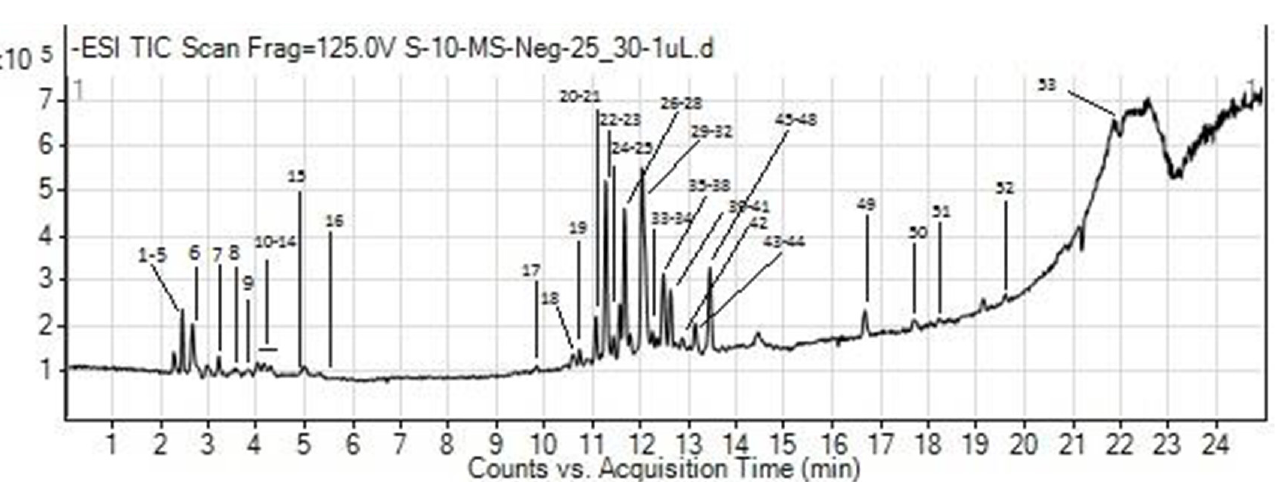
Figure 10. LC–MS chromatogram of DB–B. Table 1. List of compounds identified by LC-MS analysis of DB-B. Peak Height